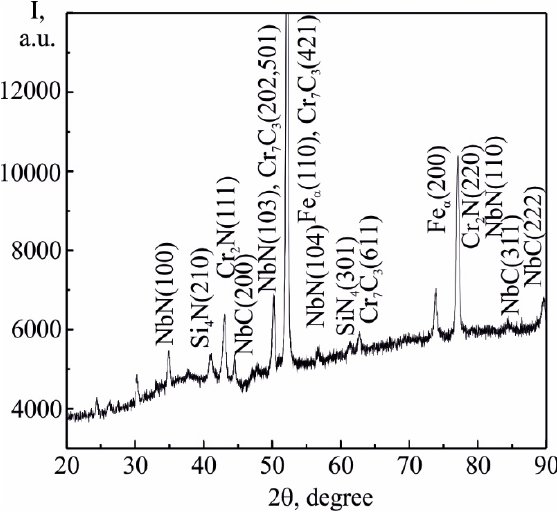
Figure 5. A diffraction pattern of a surface layer on AISI 420 steel after laser alloying with a plaster of 85Nb + 15% liquid glass.